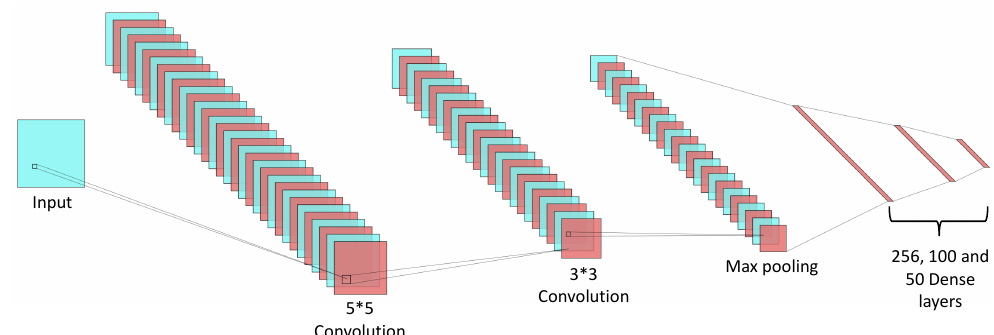
Figure 9. The architecture of the proposed network.